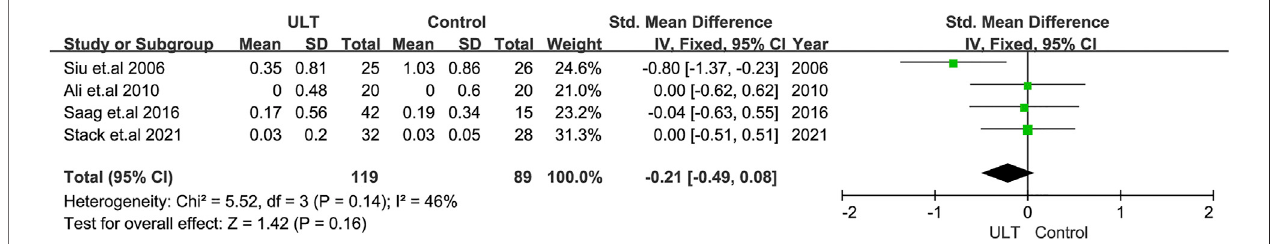
FIGURE 4 | The effect of ULT compared with the control on serum creatine. Abbreviations: SMD, standard mean difference; CI, con fi dence interval.